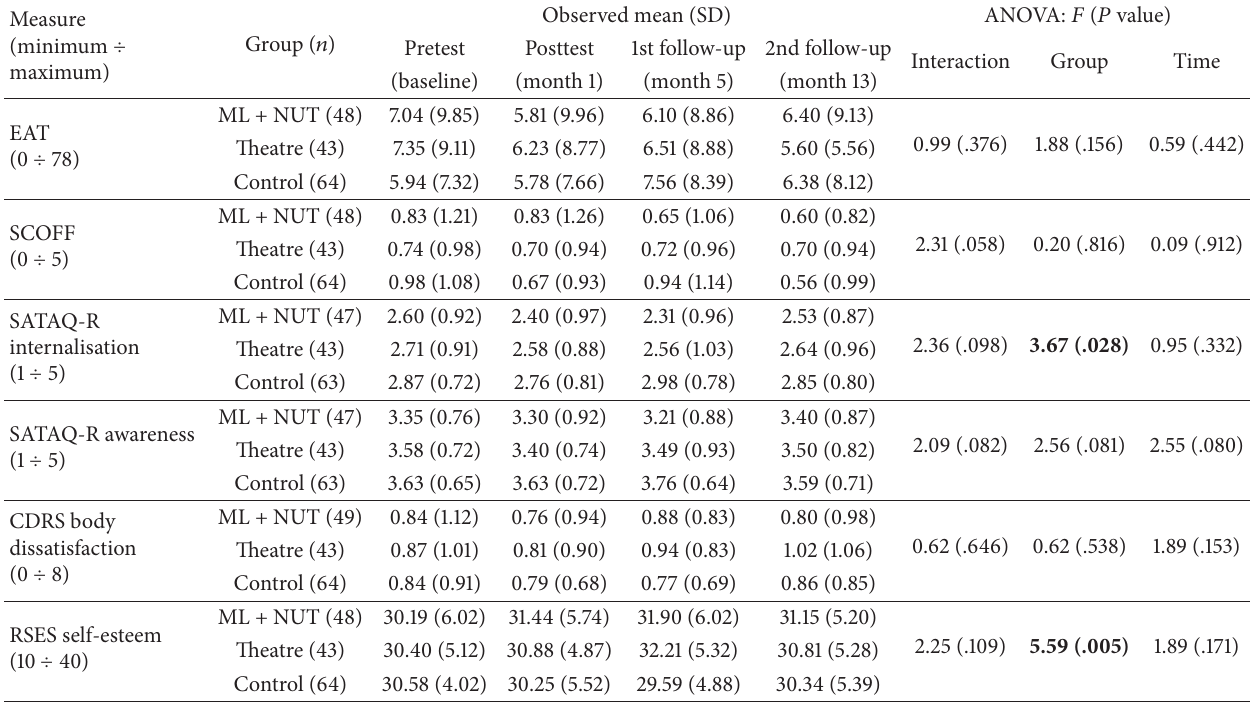
Table 2: Observed means (and SD) of measures over time and ANOVA